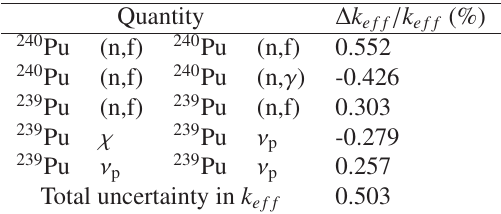
Table 7. k ef f uncertainty quantification for ALFRED with posterior JEFF-3.3 obtained with the DA of PMF001.